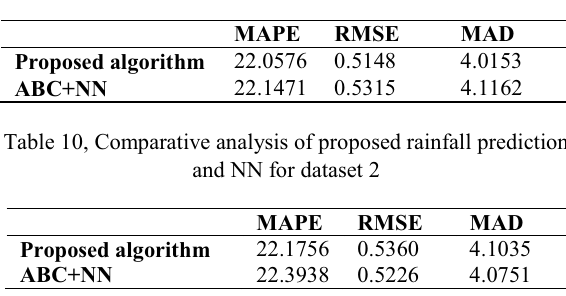
Table 9. Comparative analysis of proposed rainfall prediction